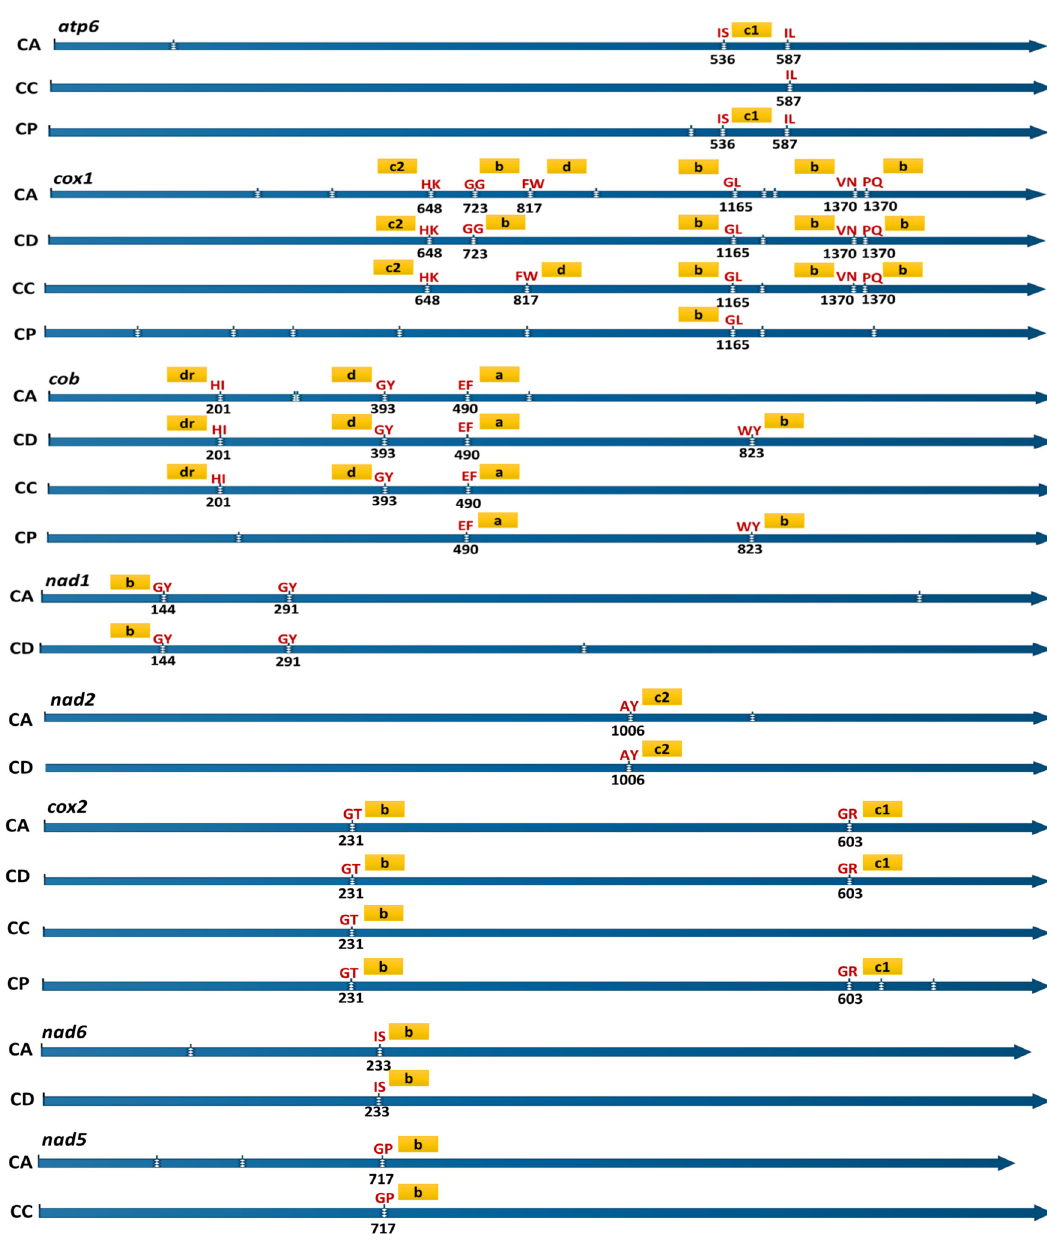
Fig 4. Conserved intron insertion position and intron type identified within the atp6 , cox1 , cob , nad1 , nad2 , cox2 , nad6 , and nad5 of C . austroafricana , C . cubensis , C . deuterocubensis and C . parasitica . Blue lines with arrow heads represent genes compared. White vertical breaks within the blue lines represent intron position with the insertion position is shown below it. Intron type is indicated by letters in gold boxes. Amino acid residues bordering the exonic sequences are shown in red single letter amino acid notation. A ; group 1A introns, b ; group 1B, c1 ; group 1C1, c2 ; group 1C2, d ; group 1D, dr ; group